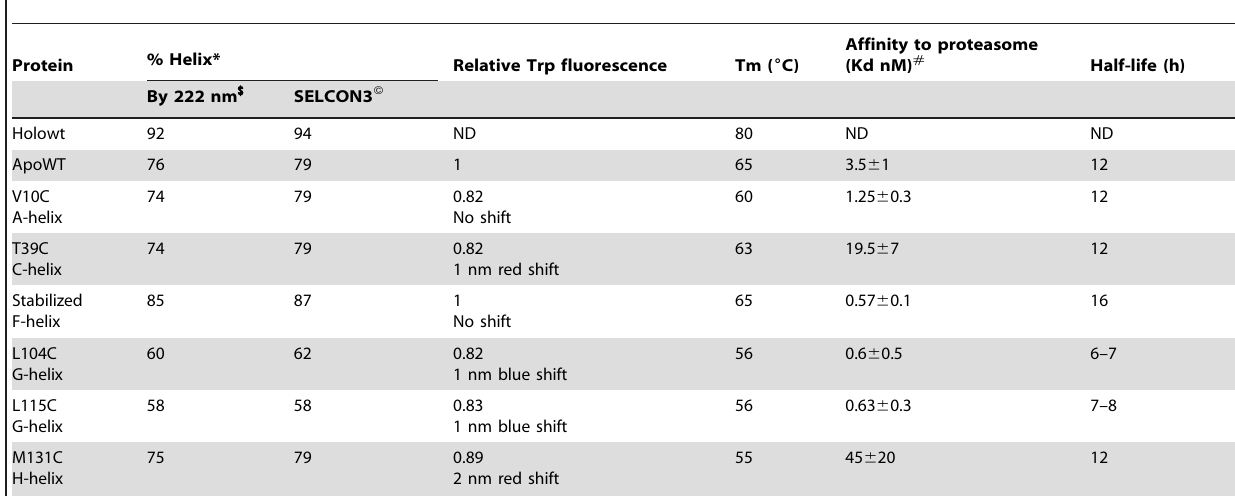
Table 2. Effect of apoMb secondary structure, Trp environment, melting temperature (Tm) and affinity (Kd) on proteasomal degradation.